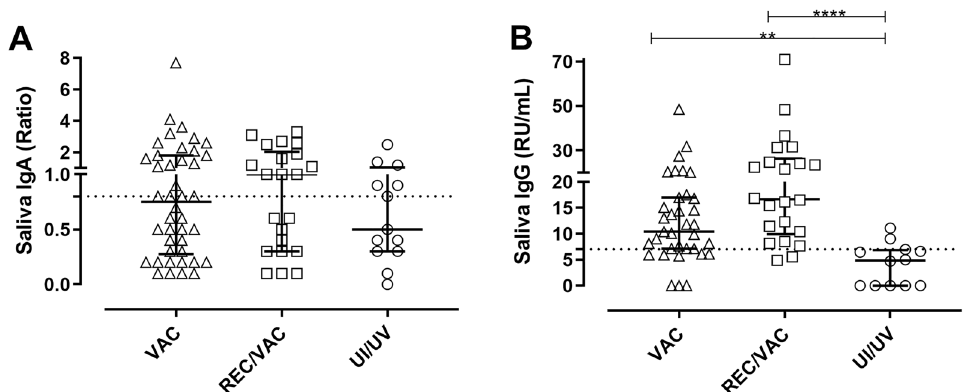
Figure 3. Salivary antibodies against SARS-CoV-2 spike protein. Saliva samples from COVID-19 vaccinated (VAC) (triangles), COVID-19 recovered vaccinated (REC/VAC) (squares) and negative control (UI/UV) individuals (circles) were analysed to determine the IgA ( A ) VAC (n = 42), REC/VAC (n = 22) and UI/UV (n = 13) and to determine the IgG ( B ) VAC (n = 35), REC/VAC (n = 22) and UI/UV (n = 13) antibodies against SARS-CoV-2 spike protein. Scatter plots show lines at the median with interquartile ranges. The dashed lines represent the cut-off value of 0.7 for IgA and 7 RU/mL for IgG. One-way ANOVA and the nonparametric Kruskal–Wallis test were used to compare the study groups. Asterisks denote statistically significant differences between the groups (** p < 0.01; **** p <